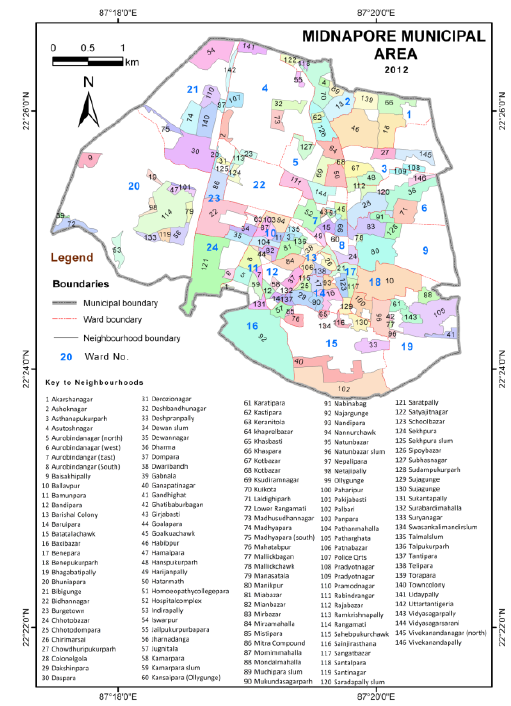
Figure 1. Location map of Study area with Neighbourhood